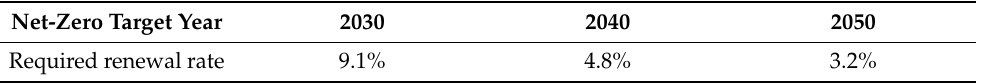
Table 3. Required renewal rates for achieving carbon neutrality in different net-zero target